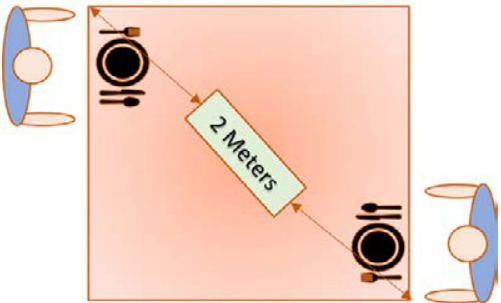
Fig. 3. Siting arrangement in the canteen or dining area without